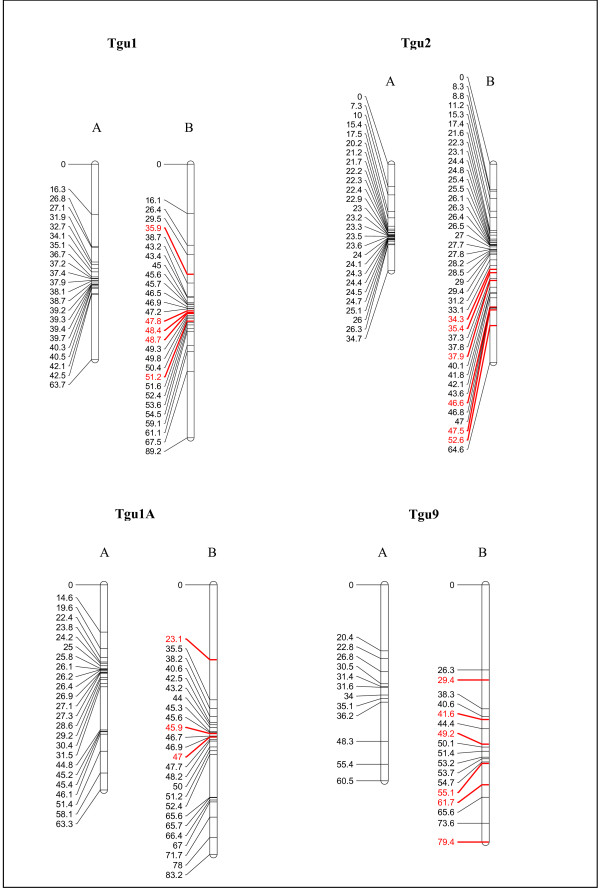
Inflation caused by adding microsatellites. Linkage maps created with (A) only the SNP markers are substantially shorter in length than (B) linkage maps created using both SNP and microsatellite markers when the conventional build method is used. This inflation is exhibited in all four chromosomes. Generally, the microsatellites (highlighted in red) are not distal to the SNP markers so the cause of the inflation is likely to be genotyping error at the microsatellite markers.